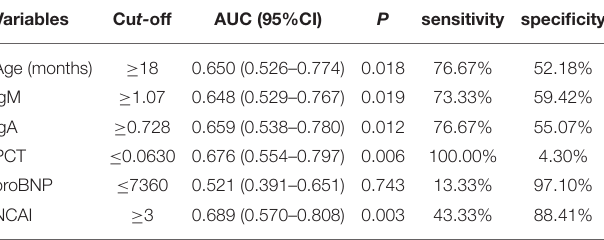
TABLE 4 | Single variable predicts the evaluation of